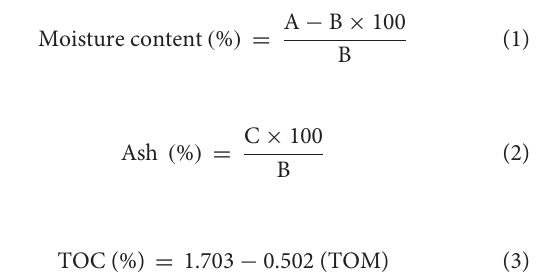
a meter (HI-9811-5 pH/EC/TDS/ ◦ C portable meter)